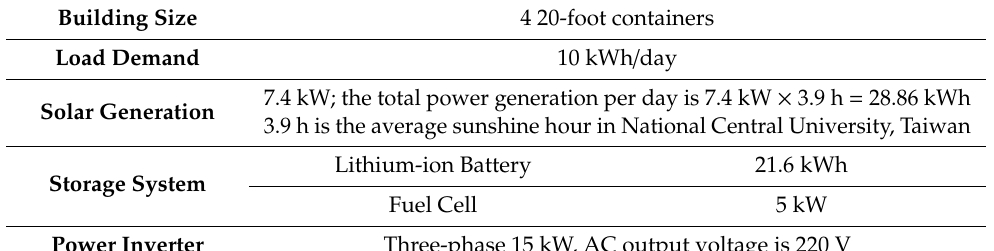
Table 5. System information of microgrid in National Central University, Taiwan.